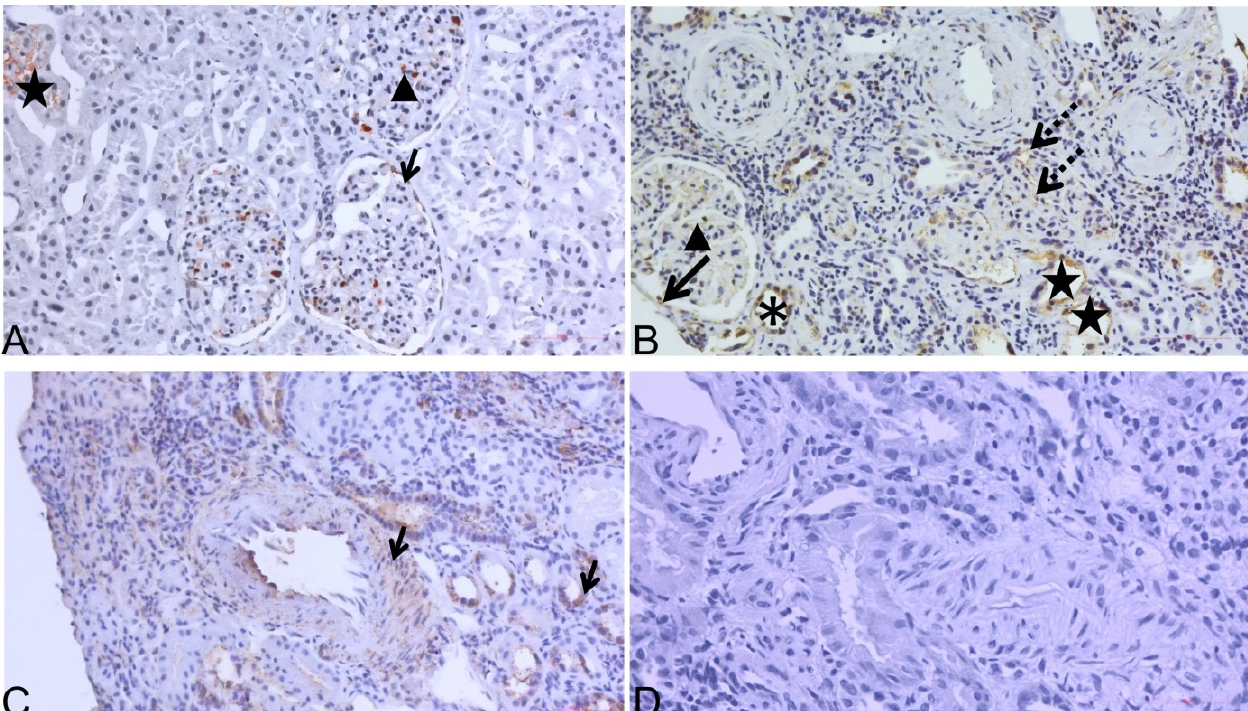
Figure 4. ADAMTS-4 expression analyses by immunohistochemistry (IHC) in transplant kidney biopsy sample pair. ( A ) Representative staining of ADAMTS-4 in “zero-time“ sample (TX0) taken at time of transplantation: positive in GC, BC, and PXT; ( B ) representative staining of ADAMTS-4 in paired TXCI biopsy sample (stage CKD-4): positive in PTC and INT, where interstitial infiltrate is also seen along with GC and damaged PXT; ( C ) ADAMTS-4 positive control: positive in artery wall of middle sized intralobular artery (black arrow—left) and DT (black arrow—right); ( D ) secondary antibody only control in kidney biopsy sample was used. Original magnification 200×. DT, asterisk; BC, black arrow; GC, black arrow head; PTC, INT, dashed arrow; PXT, black star.